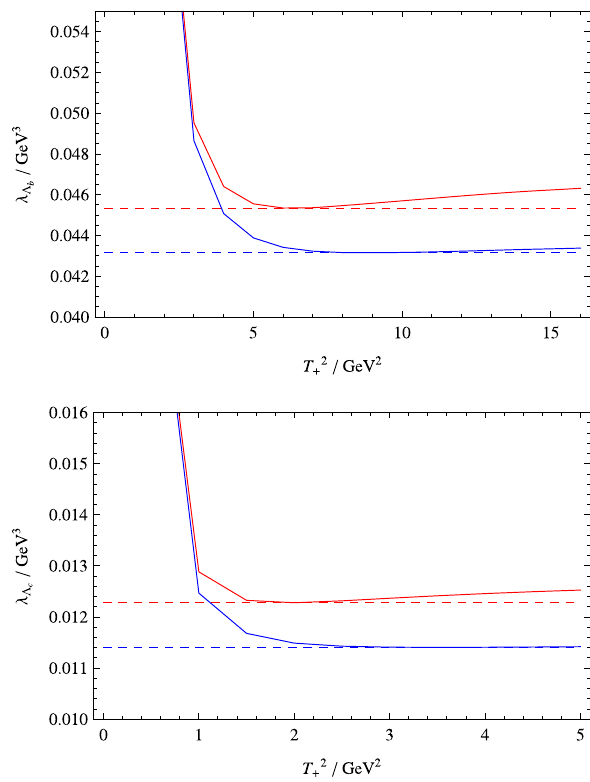
T 2 + can be found in Table 1. In practice, T 2 + is taken in the range of [ 1 , 16 ] GeV 2 with step length 1 GeV 2 for B [ 0 . 5 , 5 ] GeV 2 with b , and step length 0 . 5 GeV 2 for B c . It can be seen that our predictions for pole